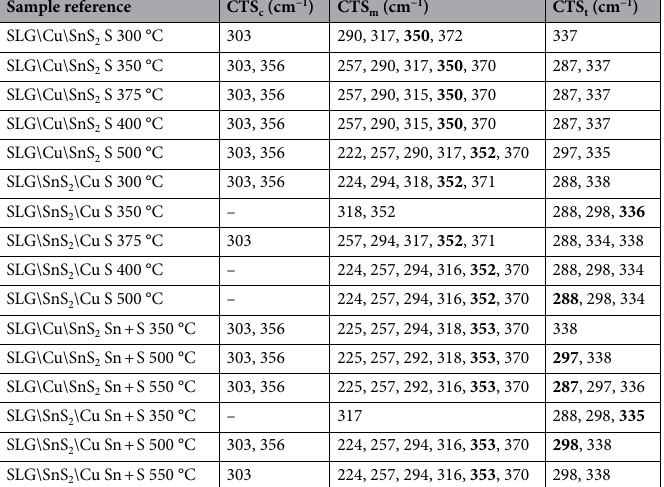
Table 2. Raman peaks of the CTS c , CTS m and CTS t structures identified or possible in this work with the principal peaks being bolded.